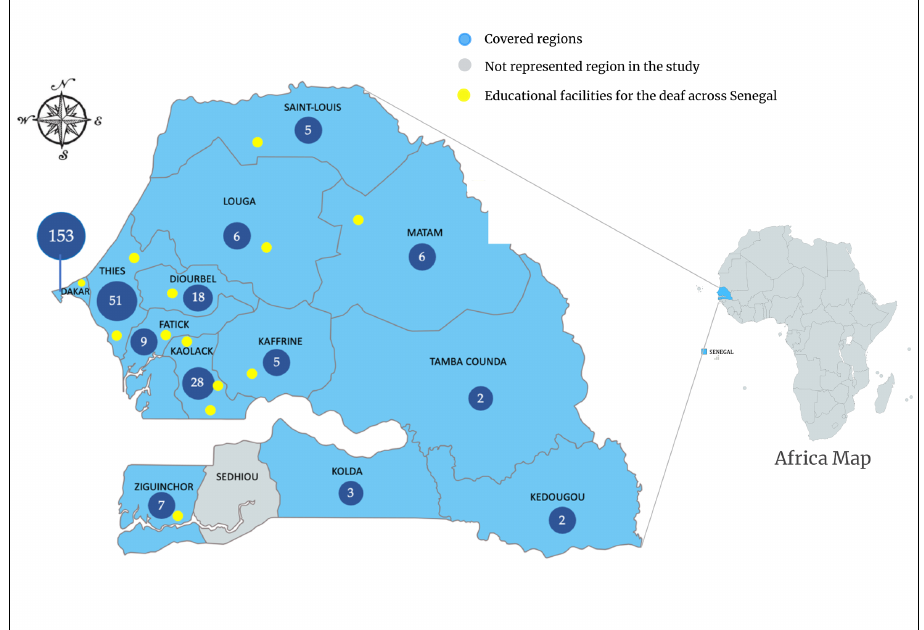
Figure 1. Regional distribution of 295 families living with HI in Senegal. More families were recruited from the Western regions, particularly in Dakar. The majority ( n = 262; 64.53%) of participants were recruited from schools for the deaf across the country (Supplementary Material Table S1). Only one administrative region has not been covered during the recruitment. The numbers on the figure correspond to the families recruited in each administrative region.